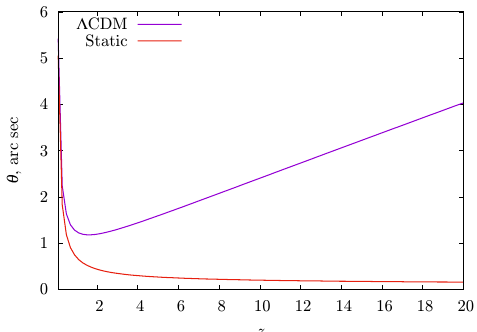
Figure 3. Angular size of a 10 kpc-size object as a function of redshift z within the framework of the static-Universe model (the red curve) as compared to the same relationship within the framework of the Λ CDM model (purple curve) for H 0 = 70kms − 1 Mpc − 1